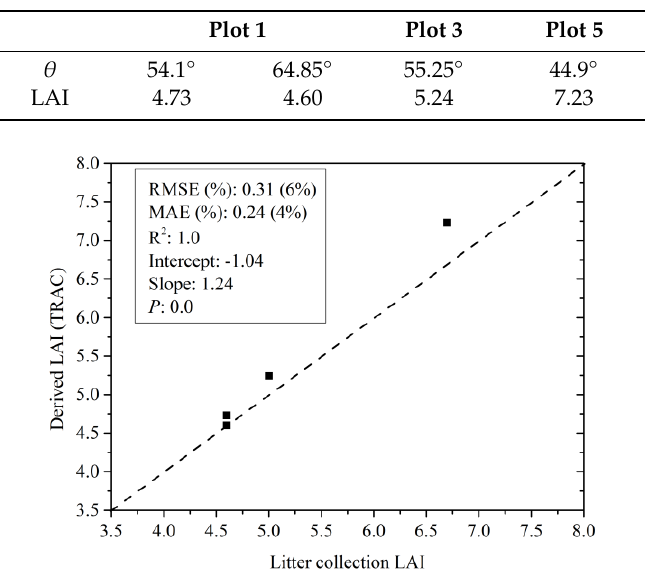
Figure 5. Comparison of LAI obtained from TRAC with litter collection LAI in the five plots. Statistics are given at 95% confidence level from the two-tailed Student’s t -test. The RMSE and MAE are expressed in LAI units (m 2 /m 2 ).